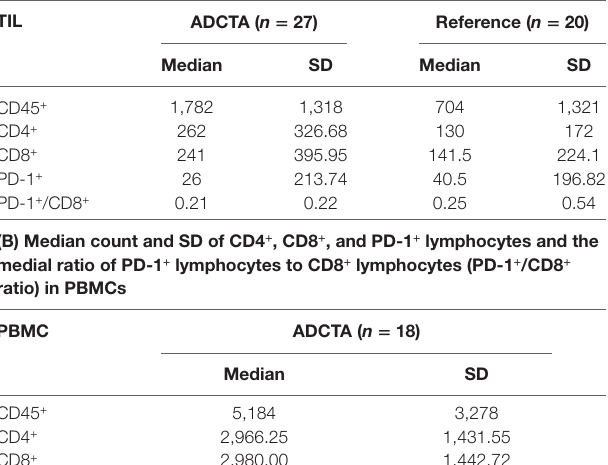
TaBle 4 | The mean, median, and SD values of total count of CD45 + , CD4 + , CD8 + , and PD-1 + lymphocytes and the ratio of PD-1 + lymphocytes in CD8 + lymphocytes (PD-1 + /CD8 + ratio) for patients in this study, in ADCTA group, and reference